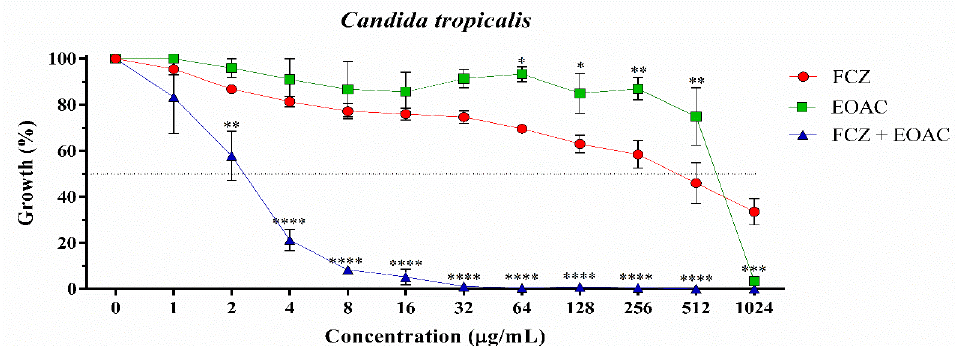
Figure 2. Cell viability curve of Candida krusei INCQS 40095 against essential oil of Acritopappus confertus (EOAC) and fluconazole (FCZ) in µ g/mL. Statistically significant value with **** p < 0.0001.